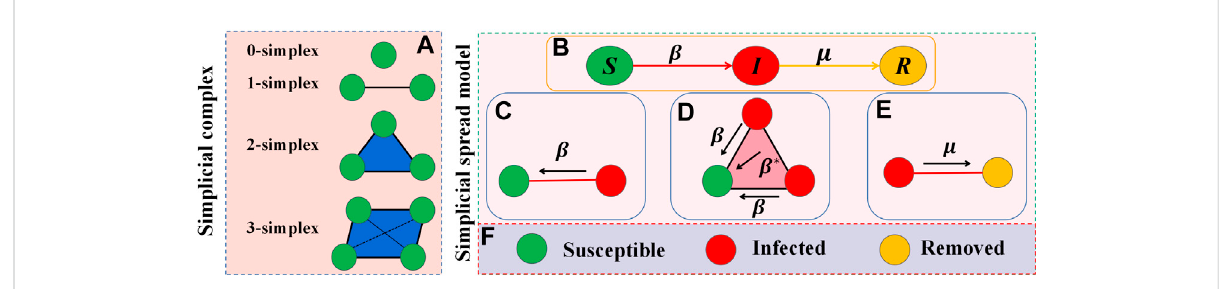
FIGURE 1 Illustration of the model description. The composition of the simplicial complex is shown in (A) . (B) Depicts the classic SIR model. Epidemic infection and recovery processes are shown in (C – E) . The “ full ” triangle denotes the 2-simplex structure, while the green, red, and yellow circles indicate susceptible, infected, and removed individuals, respectively, as shown in (F)